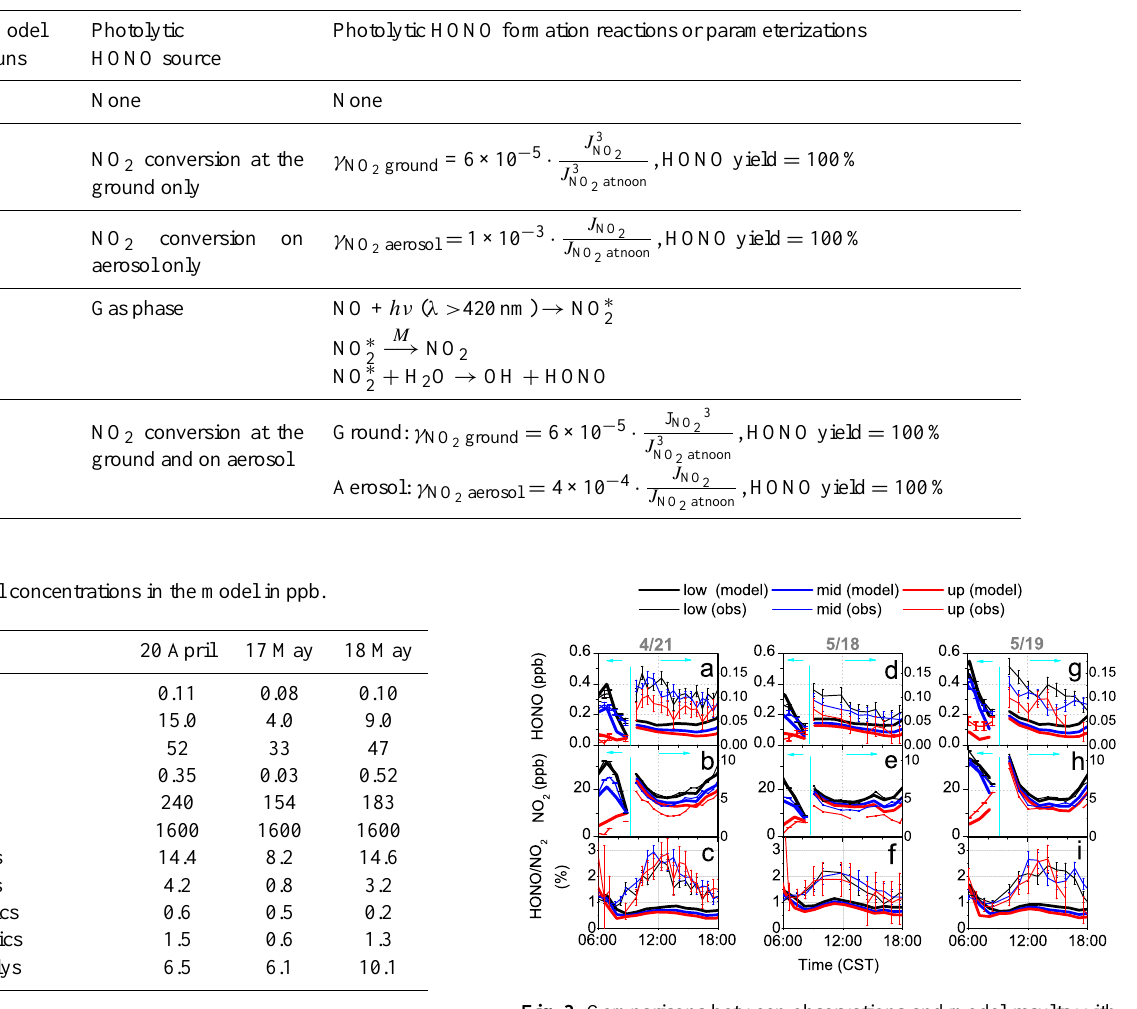
Fig. 3. Comparisons between observations and model results with- out photolytic HONO source. Shown here are daytime HONO (a, d, g) , NO 2 (b, e, h) , and HONO/NO 2 ratio (c, f, i) in the lower (black), middle (blue), and upper (red) height altitudes on 21 April (left panel), 18 May (middle panel), and 19 May (right panel). HONO and NO 2 mixing ratios after 09:00CST were magnified with a dif- ferent scale on the right axis. Error bars in this figure, and all fol- lowing figures, represent the 1-sigma statistical uncertainty of the measurements (Wong et al.,